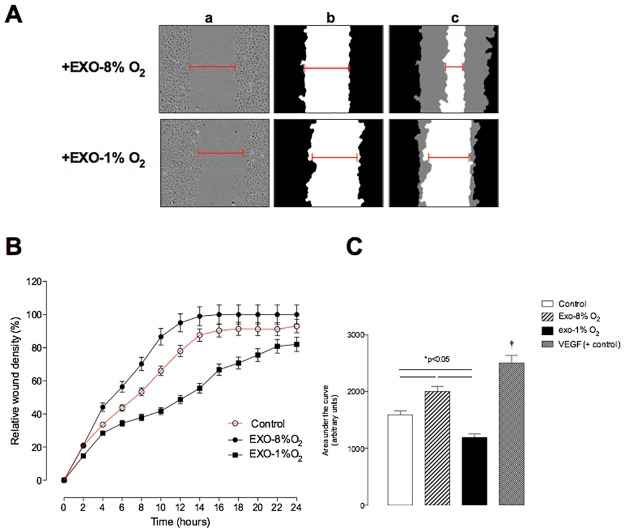
Effect of exosomes on endothelial cell migration.Endothelial cells (EC) were grown to confluence in complete media, wounds were made using 96 well WoundMaker and culture in absence or presence of exosomes (100 μg protein/ml equivalent to 5 x 108 vesicles per ml) obtained from EVT cultured under 8% or 1% O2. (A) a, EC image immediately after wounding; b, Graphical representation showing the calculation of initial wound width; c, Graphical representation of cell migration at the midpoint of the experiment. (B) The time course of the effect of exosomes on EC. (C) Area under curves from data in B. Data represents n = 12 well for each point (6 different experiment in duplicate) Values are mean ± SEM. †p<0.05 versus all values.